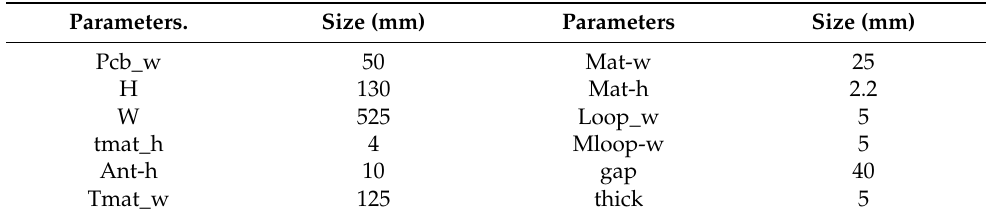
Table 1. Optimized tag antenna parameters.